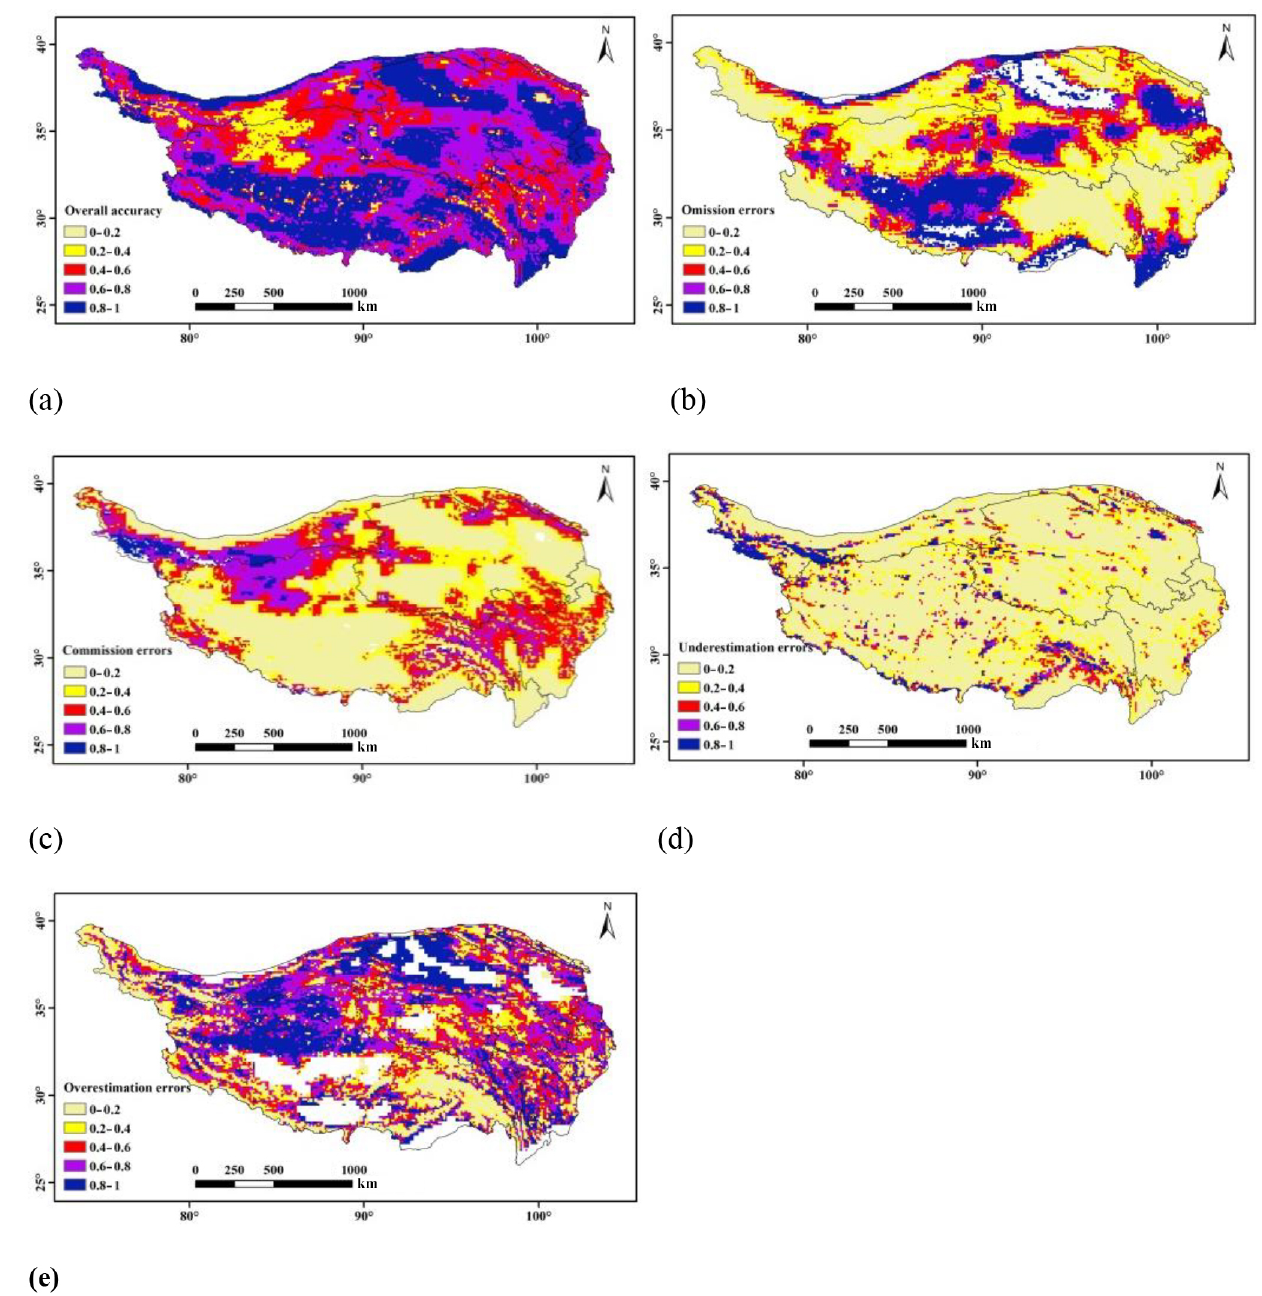
Figure 4. Spatial distributions of the general accuracy (a) , omission errors (b) , commission errors (c) , underestimation errors (d) and over- estimation errors (e) of AMSR-E across the